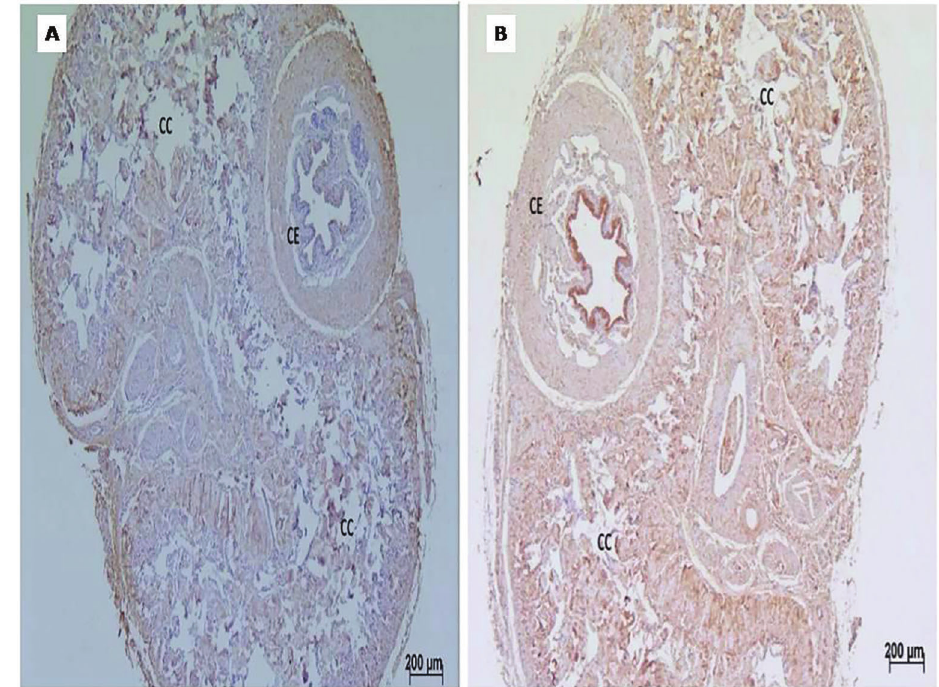
Figure 2. Representative immunohistochemical photomicrography of the overall expression of endothelin B ( Panel A ) and A ( Panel B ) protein in cross-section of the rat cavernous bodies of the alcoholic-diabetic group. Diffuse marking on the erectile tissue can be seen, especially close to the tunica albuginea for endothelin B. Cavernous body (CC); Spongy body (CE). Magni fi cation: 50 (cid:1) .